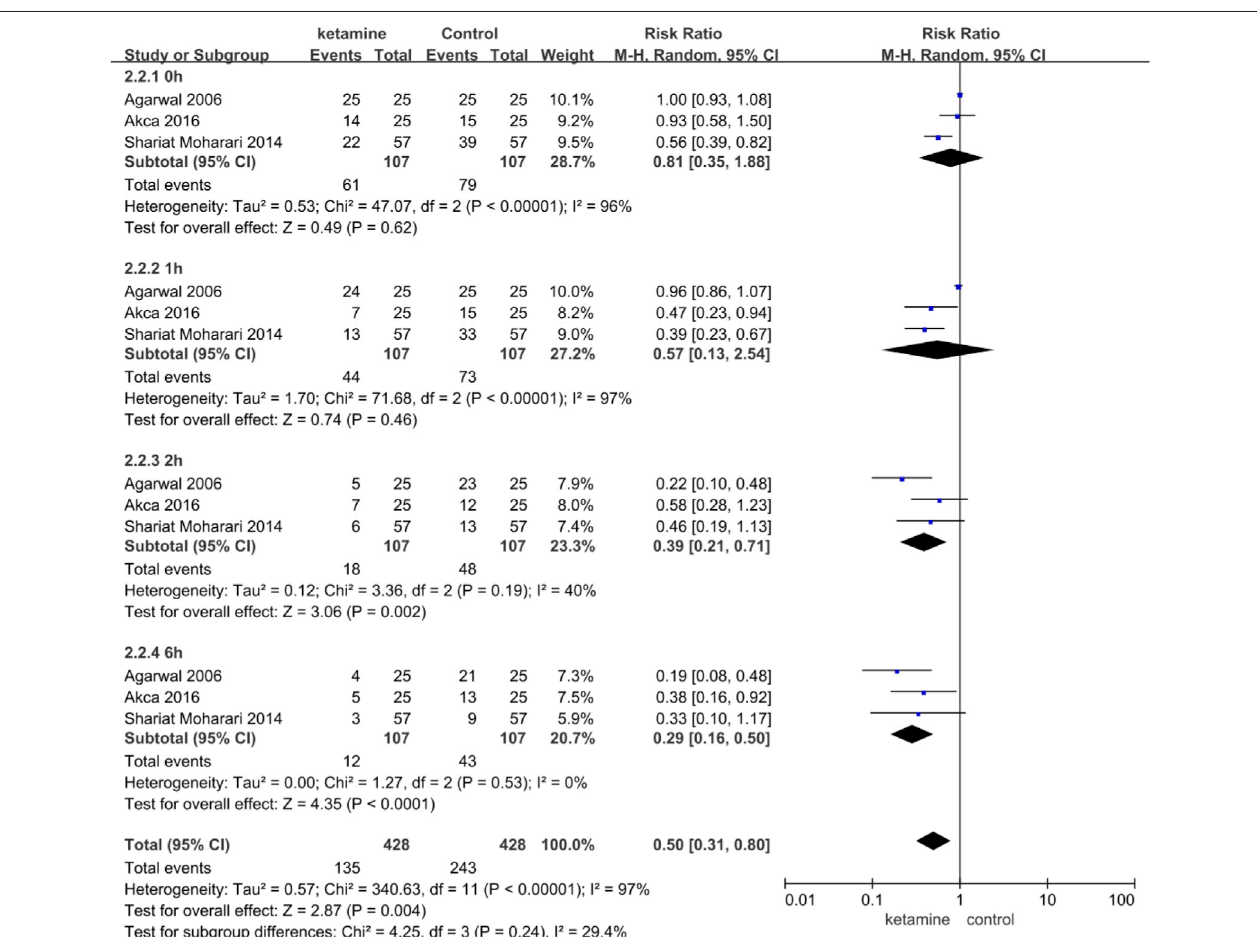
FIGURE 4 | Incidence of catheter-related bladder discomfort in ketamine vs. placebo.